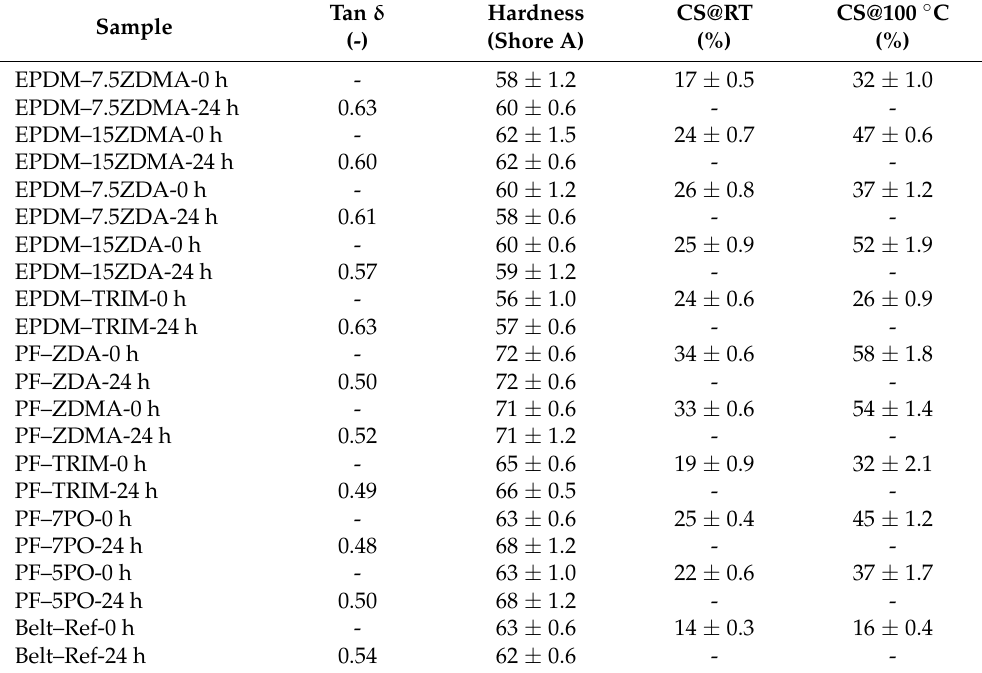
Table 6. Tan δ , Shore A haradness, and compression set properties of reinforced EPDM